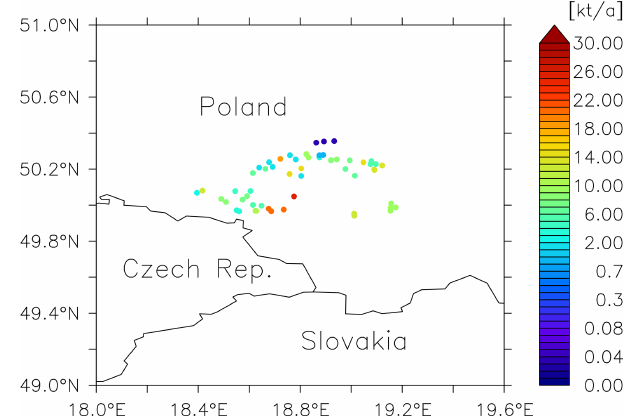
Figure 4. The map shows the locations and the emissions of methane in tons per year of the ventilation shafts in the USCB (CoMet ED v1). All ventilation shafts are gathered in the south-west of Poland close to the polish city Katowice and the Czech